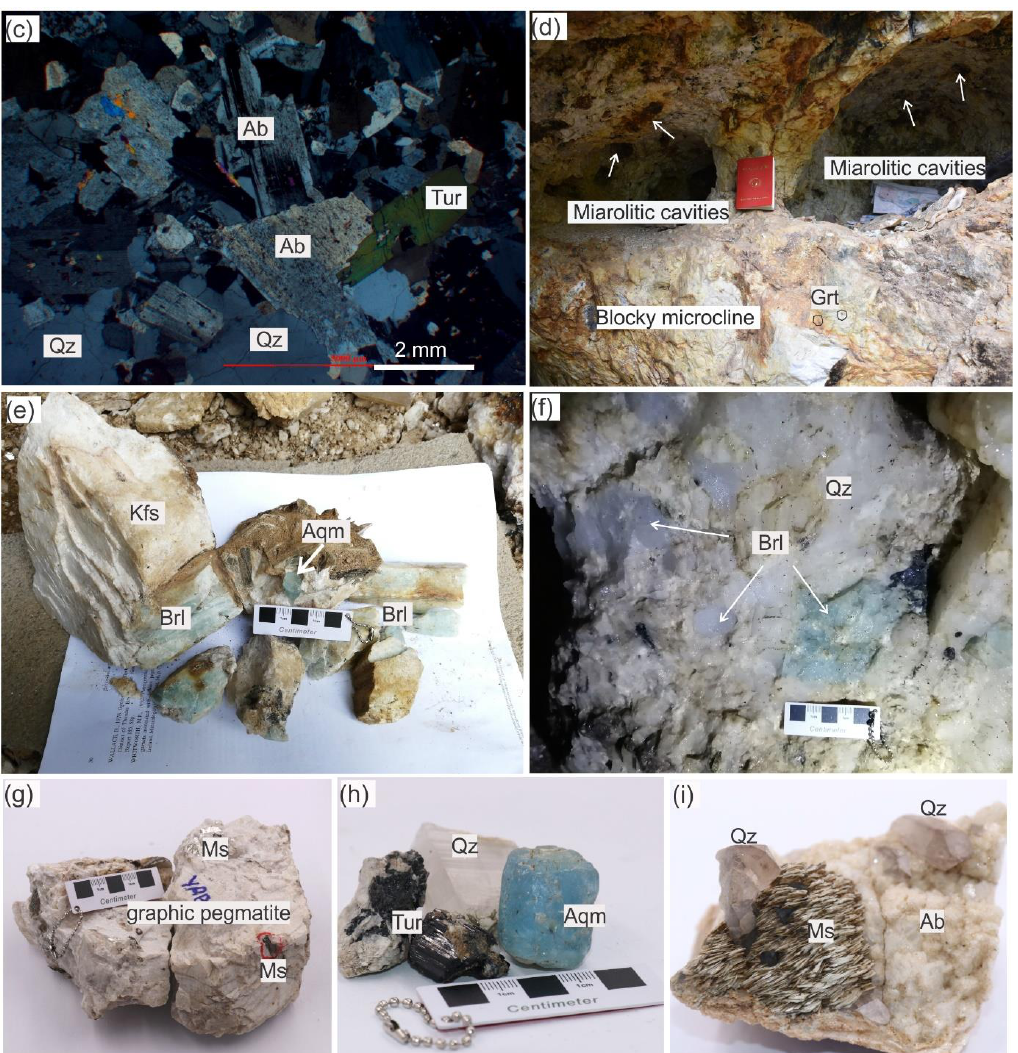
Figure 4. Field photographs and photomicrographs of the Yamrang Pegmatite. ( a ) Yamrang Pegmatite and host-rock gneiss contact zone; ( b ) Biotite-rich schistose gneiss hosting Yamrang Pegmatite under plane-polarized light; ( c ) Sample from saccharoidal albite zone showing albite-quartz assemblage; ( d ) Blocky perthitic microcline zone with miarolitic cavities; ( e ) Beryl and aquamarine in association with K-feldspar; ( f ) Quartz-beryl association from core zone; ( g ) Pegmatite sample showing graphic texture; ( h ) Aquamarine, quartz, and tourmaline gems from Yamrang Pegmatite; ( i ) Smoky quartz, muscovite books and albite assemblage from miarolitic cavities. Mineral abbreviations: Ab, albite; Aqm, aquamarine; Brl, beryl; Bt, biotite; Grt, garnet; Kfs, K-feldspar; Ms, muscovite; Pl, plagioclase; Qz, quartz; Tur, tourmaline. Mineral abbreviations are after